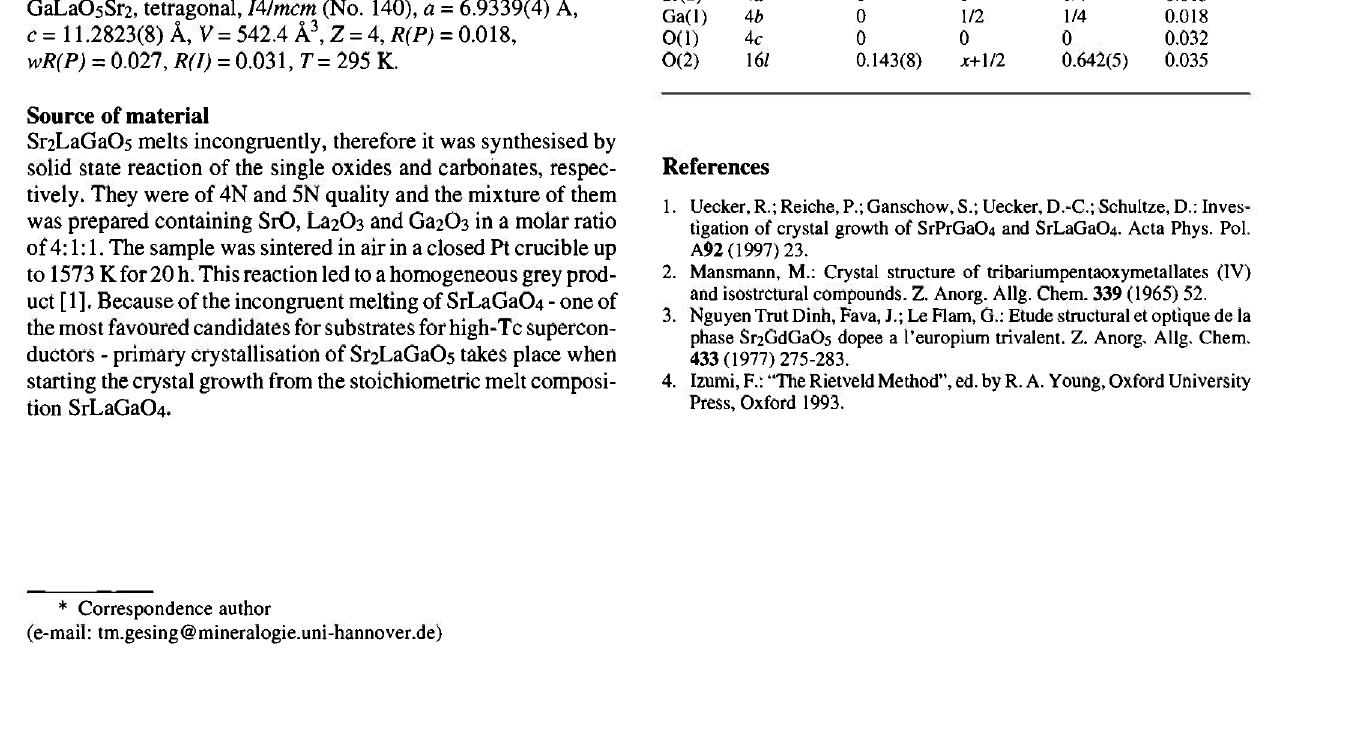
Table 1. Data collection and handling. Powder: grey Wavelength: Diffractometer: